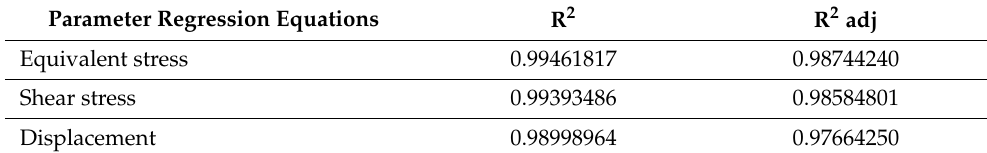
Table 5. The values of R 2 and R 2 adj, respectively, for the regression equations.